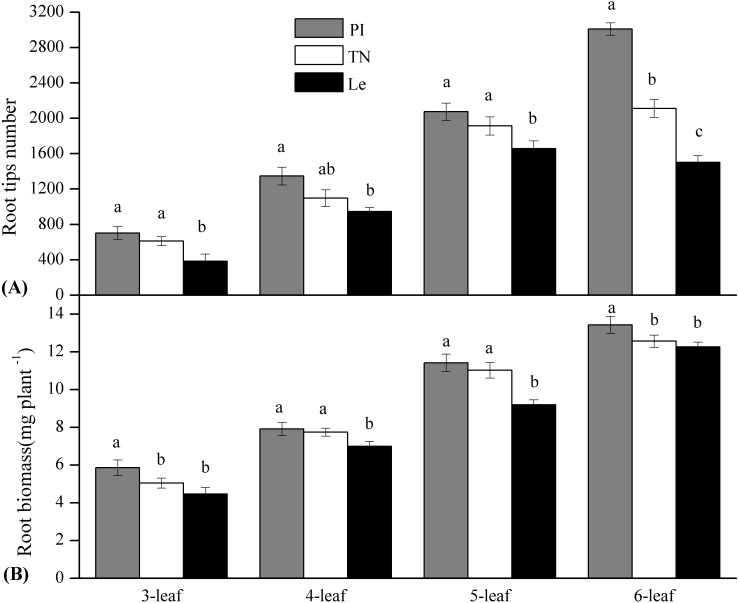
Root tips number and root biomass (mg plant−1) of the three rice cultivars (PI and TN, allelopathic cultivars PI312777 and Taichung Native1; Le, non-allelopathic cultivar Lemont) at 3–6 leaf stages.Significant differences (P < 0.05) between rice cultivars at the same leaf stage were indicated by different lowercases, according to Tukey’s honestly test.